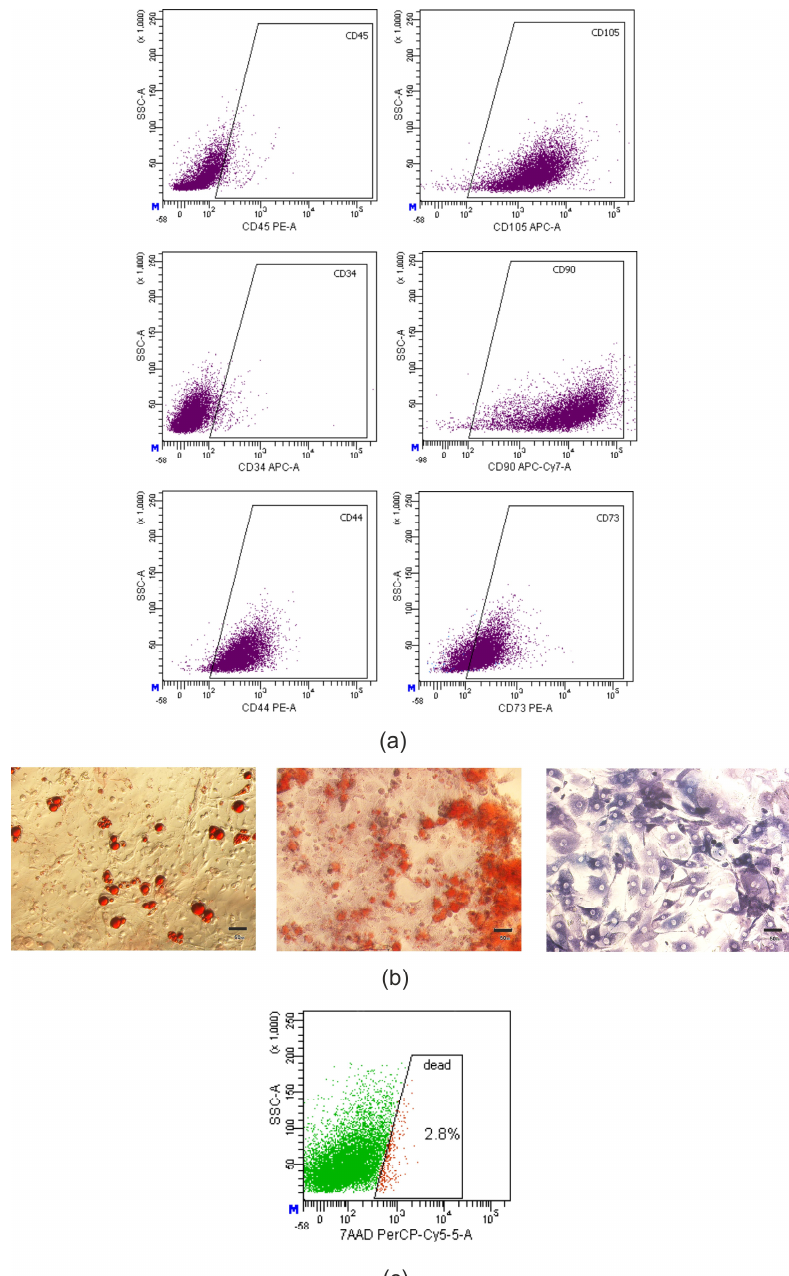
Figure 4. Murine AD-MSCs cultures met the minimal criteria to define MMSCs. ( a ) dot-plot histograms of CD44, CD73, CD90, CD105, CD34 and CD45 markers expression in the culture of murine AD-MSCs according to flow cytometry, 2nd passage. ( b ) photomicrographs of murine AD-MSCs cultures after directed adipogenic (left) and osteogenic (middle and right) differentiation on the 21st day of culturing. Lipid droplets stained with Oil Red O (red); calcium deposits in mineralized extracellular matrix stained with Alizarin Red S (pink); alkaline phosphatase stained with BCIP/NBT (violet); light microscopy. Scale bar = 50 μm. ( с ) dot-plot histogram of AD-MSCs viability after thawing, 7-aminoactinomycin D (7-AAD) staining.